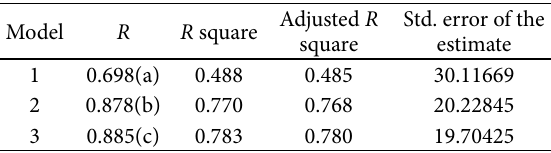
a indicators: trip frequency, constant b indicators: z 1, trip frequency, constant c indicators: z 1, z 2, trip frequency, constant d response variable: the square of number of trips